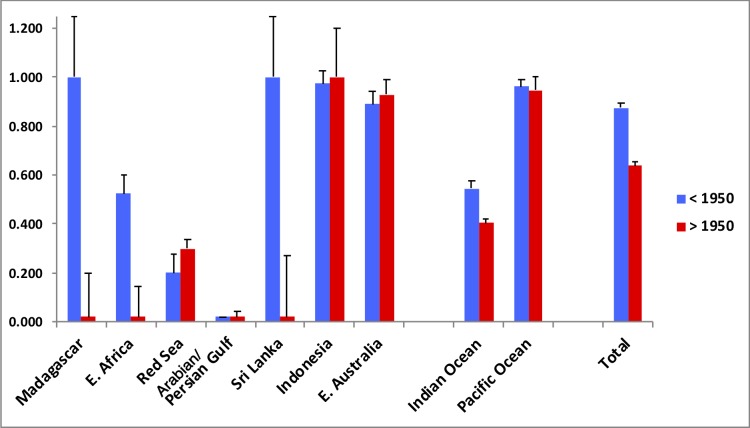
Unbiased haplotype diversities (and SEs) for samples collected before 1950 (<1950) and after 1950 (>1950).Sample sizes are listed in S2 Table.